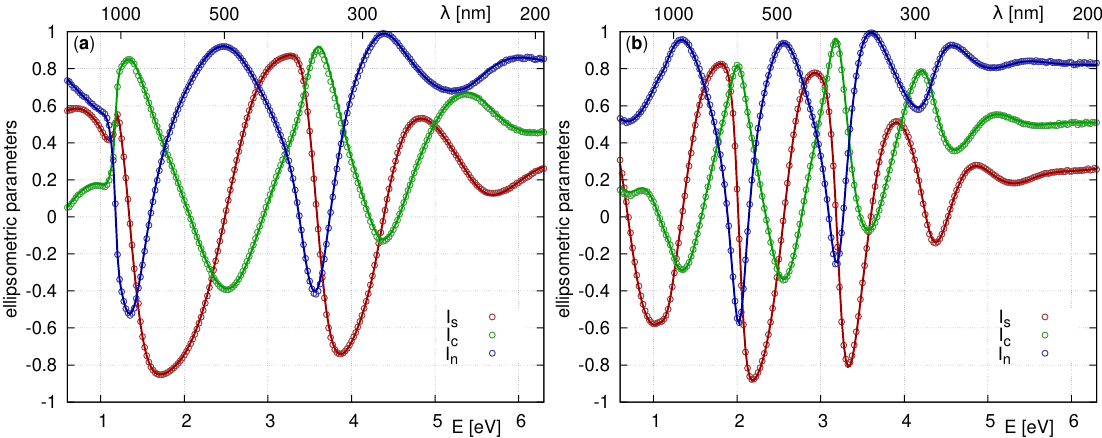
Figure 5. Spectral dependencies of the associated ellipsometric parameters of Sample 2 ( a ) and Sample 3 ( b ) at incidence angle 70 ◦ : points denote the measured values, curves denote the theoretical